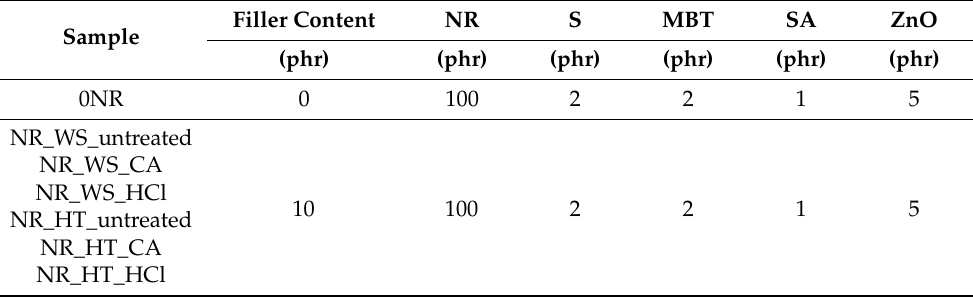
Table 1. Composition of rubber